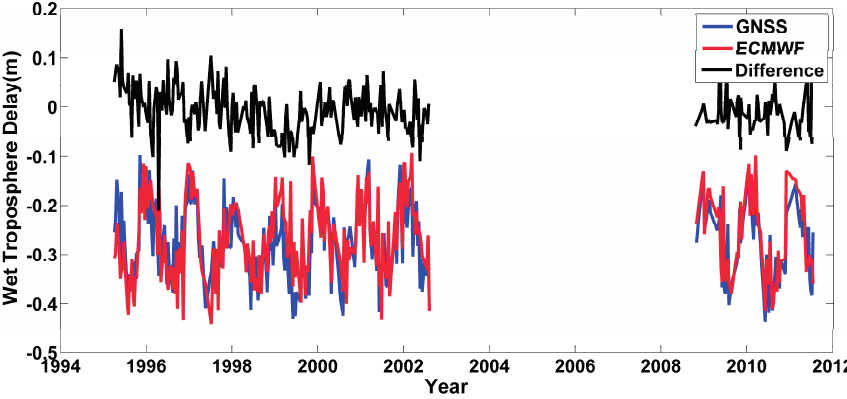
Figure 5. Comparison of the retracked altimetric LSHs with and without terrain gradient correction ( a ) in Tuku and ( b ) in Yuanchang. Means of LSHs are removed.